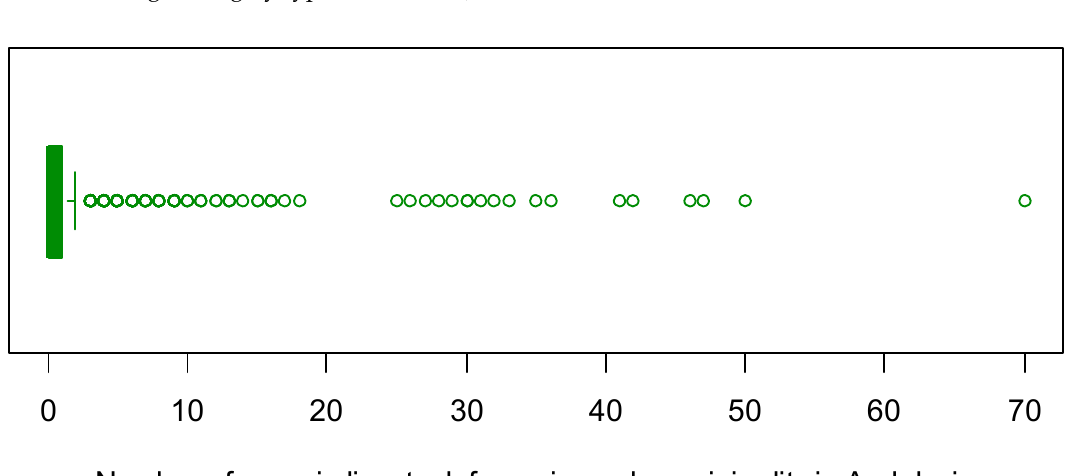
Figure 4. Box plot of total organic livestock farms. This distribution has an appropriate degree of asymmetry for the Waring distribution to be used with the standardized skewness of 63.65.